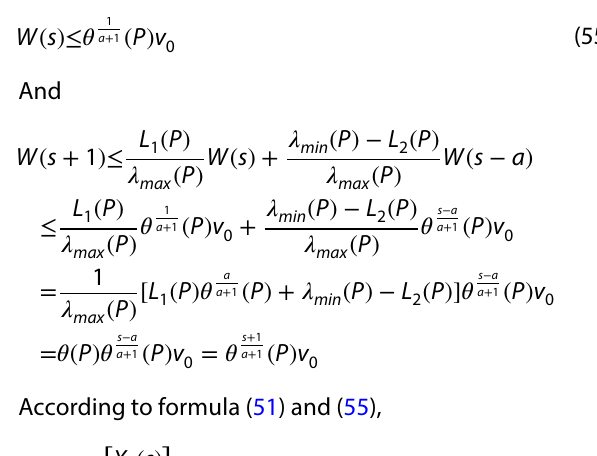
Table 1 The 2-dimensional class centers and